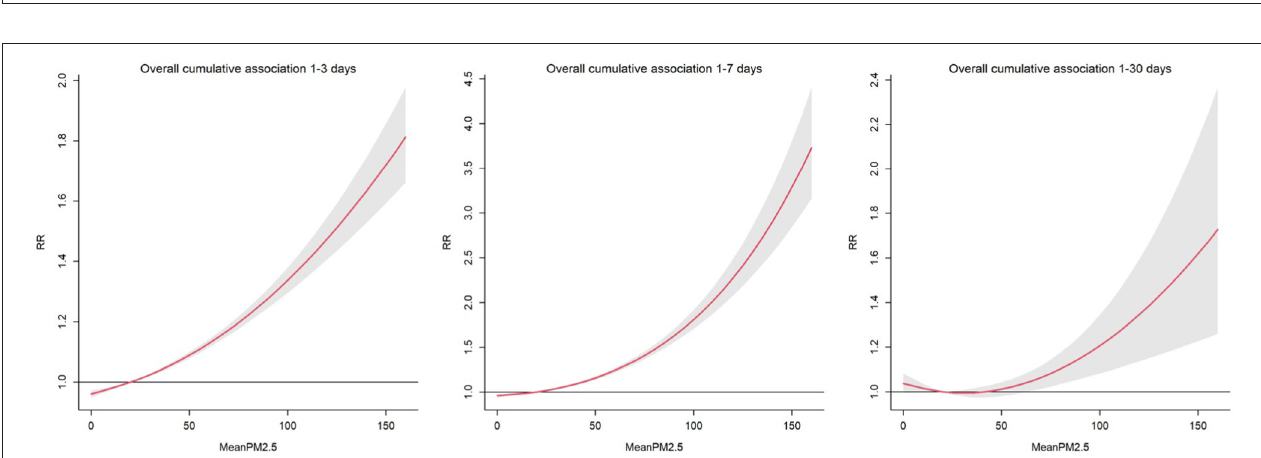
FIGURE 3 | Relative risk and 95% confidence intervals for daily pediatric respiratory outpatients with per unit increase of PM 2.5 at different cumulation lag